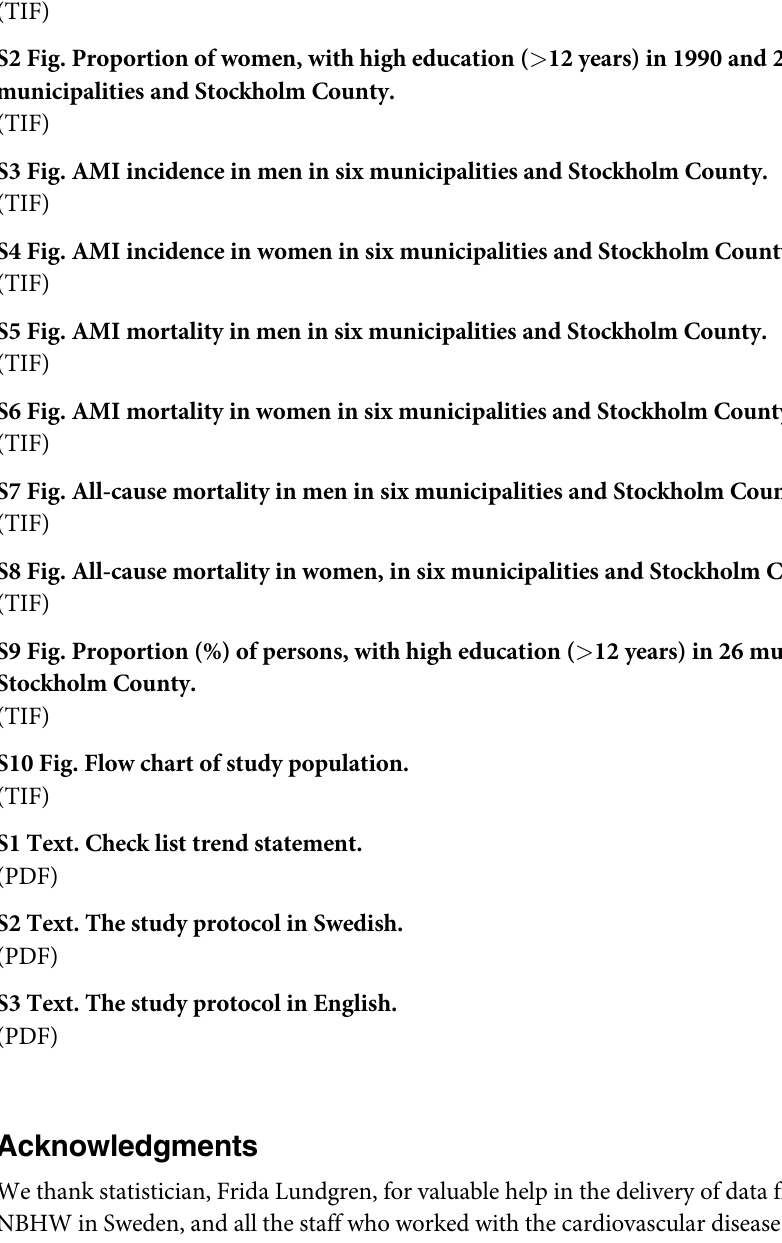
S3 Fig. AMI incidence in men in six municipalities and Stockholm County. S4 Fig. AMI incidence in women in six municipalities and Stockholm County. S5 Fig. AMI mortality in men in six municipalities and Stockholm County. S6 Fig. AMI mortality in women in six municipalities and Stockholm County. S7 Fig. All-cause mortality in men in six municipalities and Stockholm County. S8 Fig. All-cause mortality in women, in six municipalities and Stockholm County. S9 Fig. Proportion (%) of persons, with high education ( > 12 years) in 26 municipalities of Stockholm County. S10 Fig. Flow chart of study